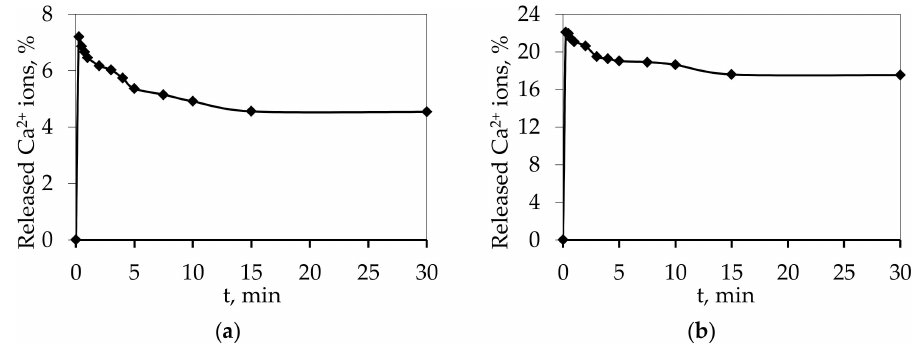
Figure 3. The amount of released calcium ions from adsorbent, when the initial concentration of Co 2+ was equal to 0.25 g/dm 3 ( a ) and 1 g/dm 3 ( b